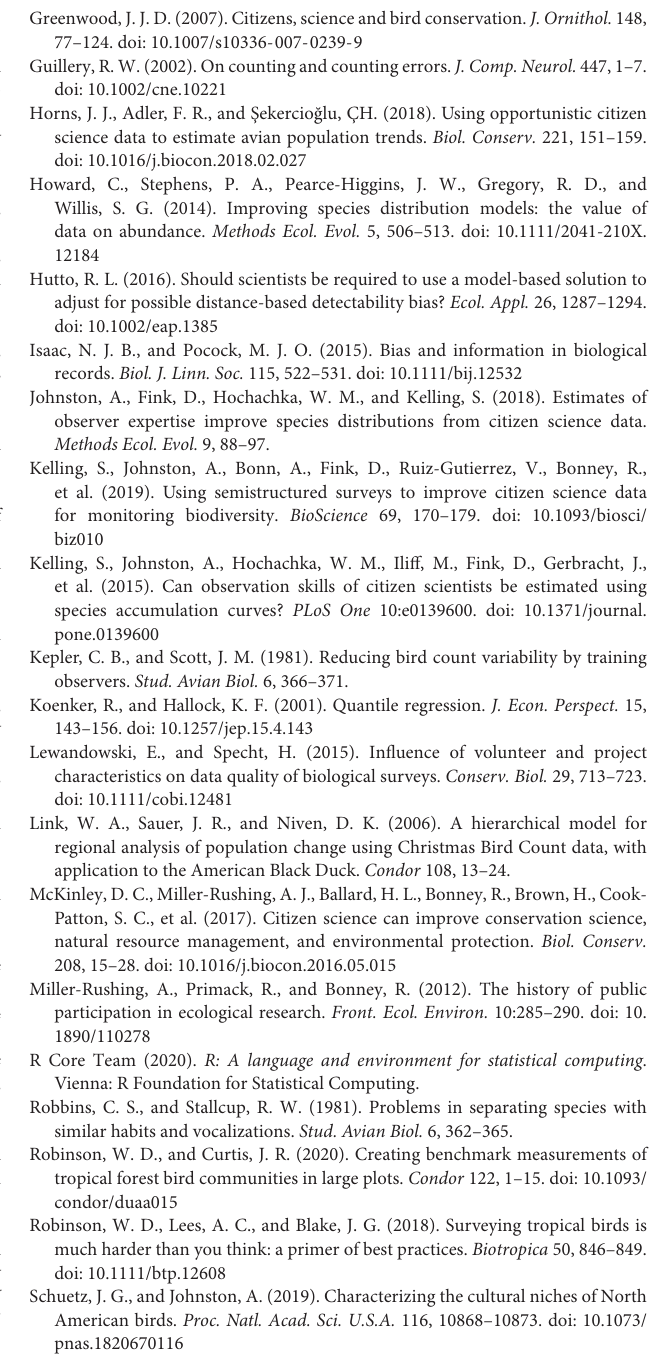
Supplementary Figure 2 | Counts of waterbirds in eBird checklists included in our analyses as a function of their percent error. Supplementary Figure 3 | Relationship between mean percent error on eBird checklists (blue line) and mean waterbird abundance (green line) as a function of day of year at Philomath ponds, Oregon USA, 2010–2019. Waterbird abundance is the mean of all the counts ( R ∗ ) of all of the possible 20 study species present each day across the 10 years.